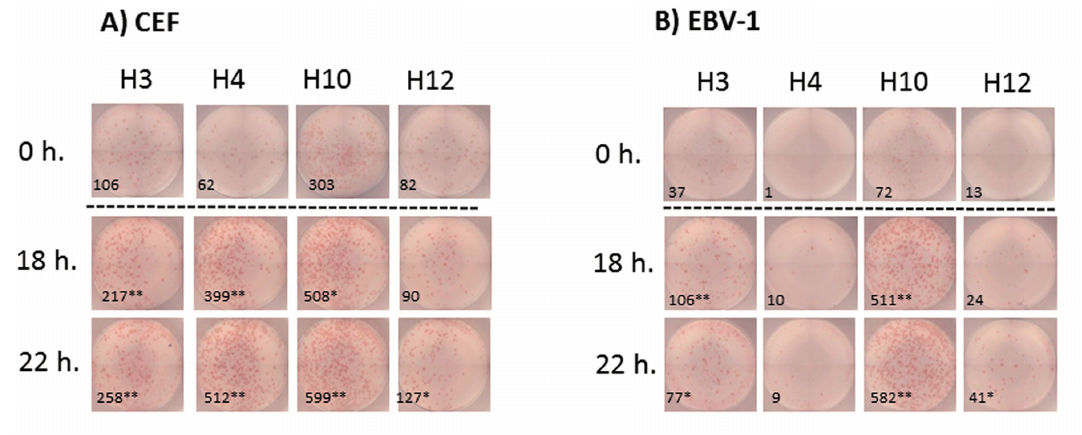
Figure 4. Representative images of the IFN  ELISPOT performed with previously frozen PBMC. PBMC samples from donors H3, H4, H10 and H12 were thawed and stimulated ( A ) with the A2-CEF pool or ( B ) with EBV-1. PBMCs were not rested (0 h) or rested for 18 h or 22 h prior to testing. Each picture is a representative of triplicate wells. Responses method with Westfall–Young max-T correction; 5% or 10% significances are denoted by (**) or (*),